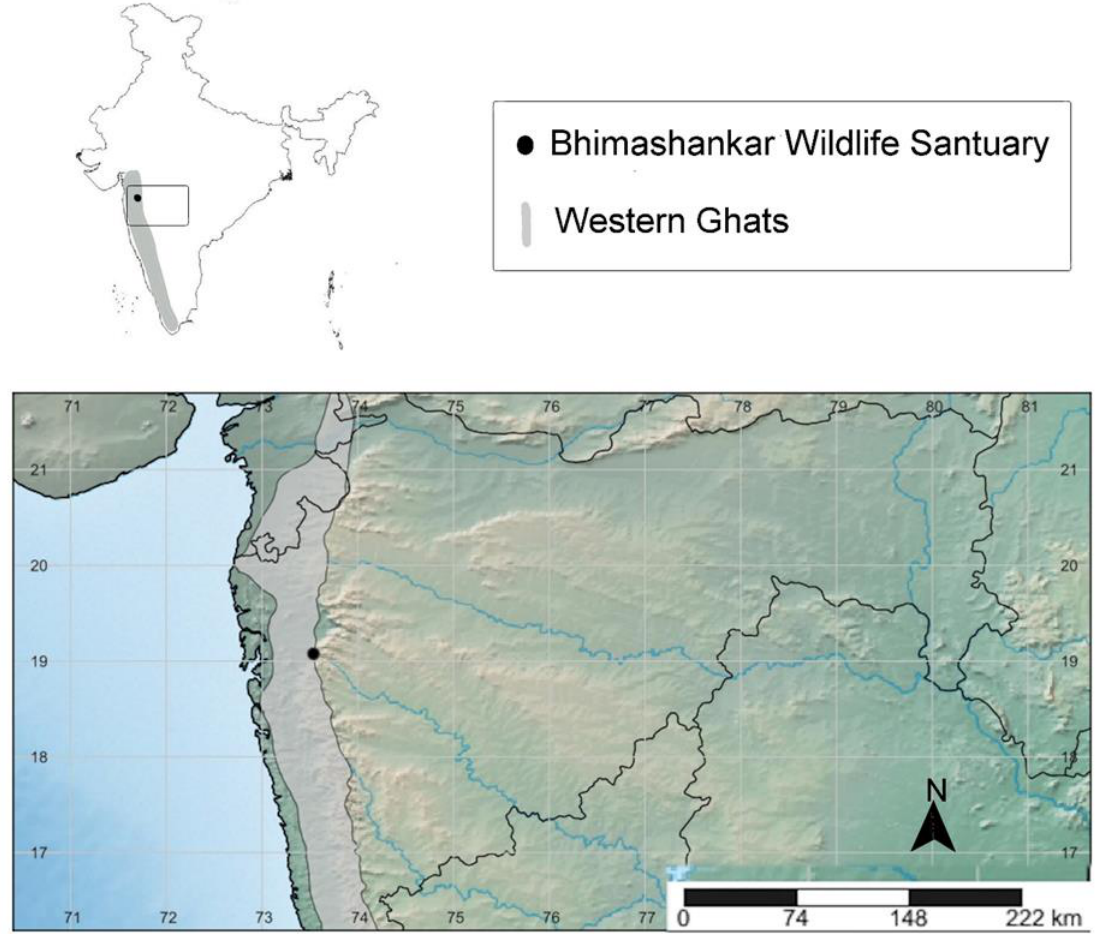
F IGURE 1. Site location of Bhimashankar Wildlife Sanctuary within the Western Ghats of